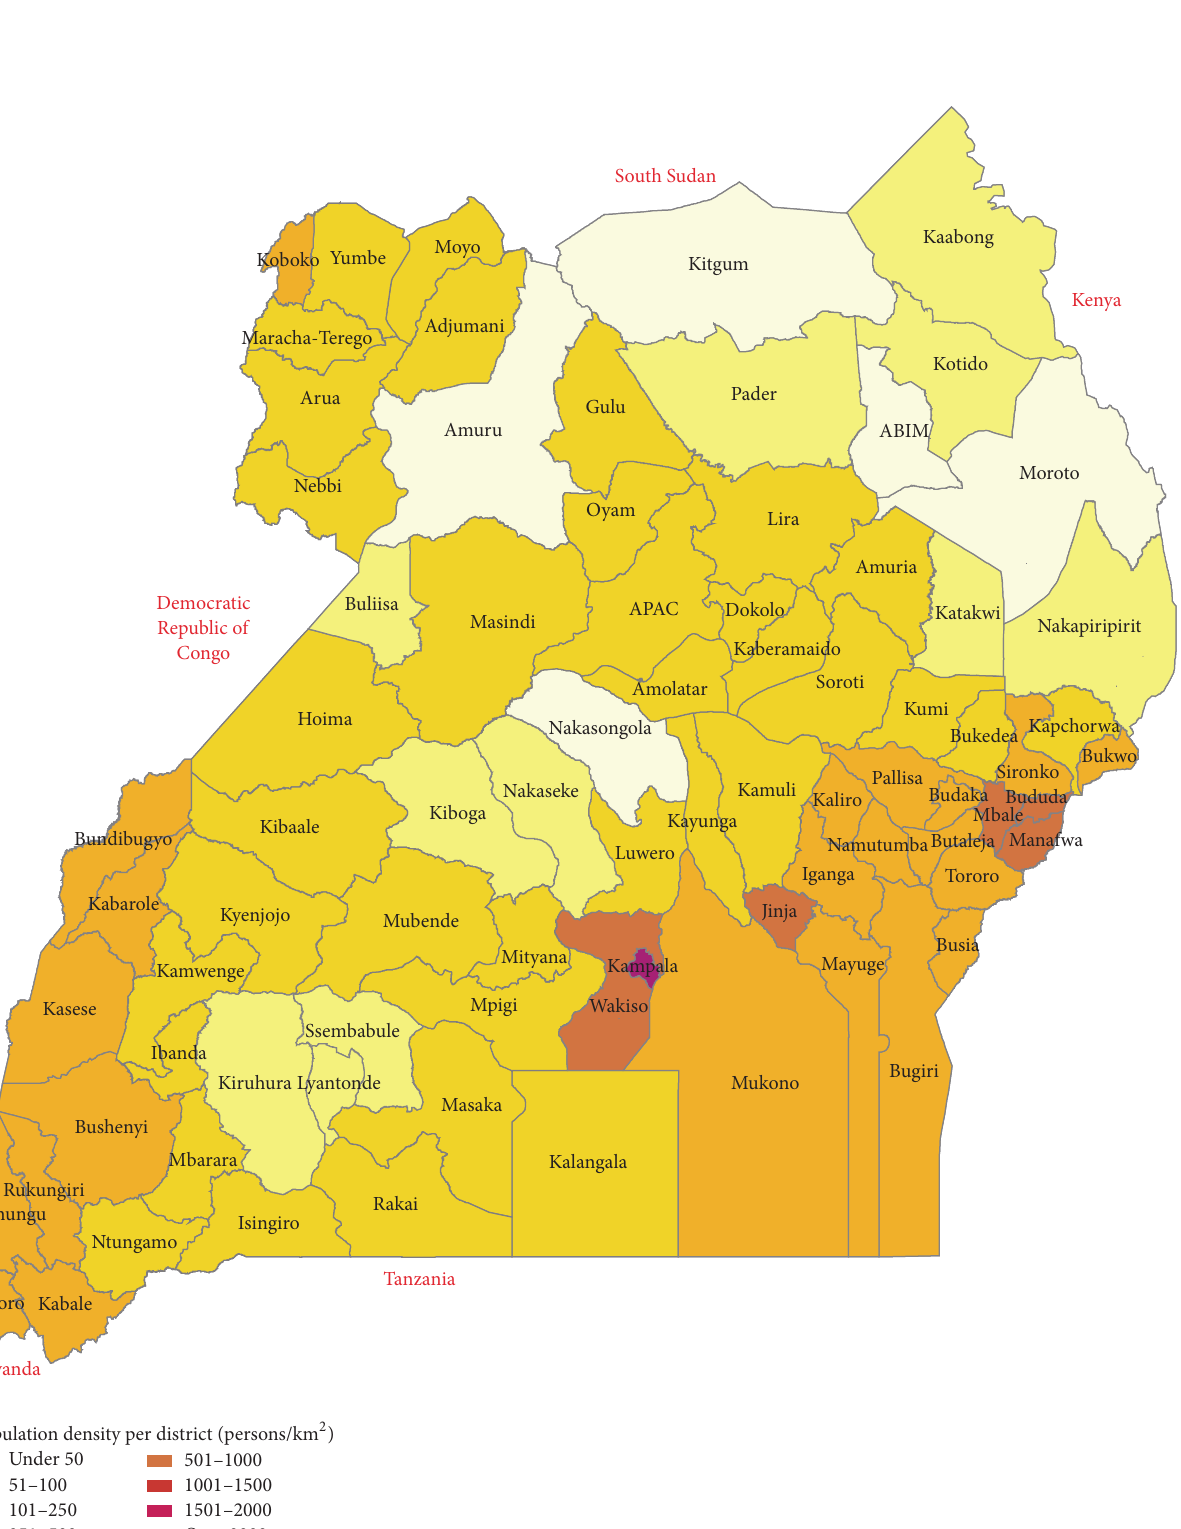
Figure 2: The population density of the various districts of Uganda by 2010 (source: Uganda Water Supply Atlas 2010, Ministry of Water and Environment,